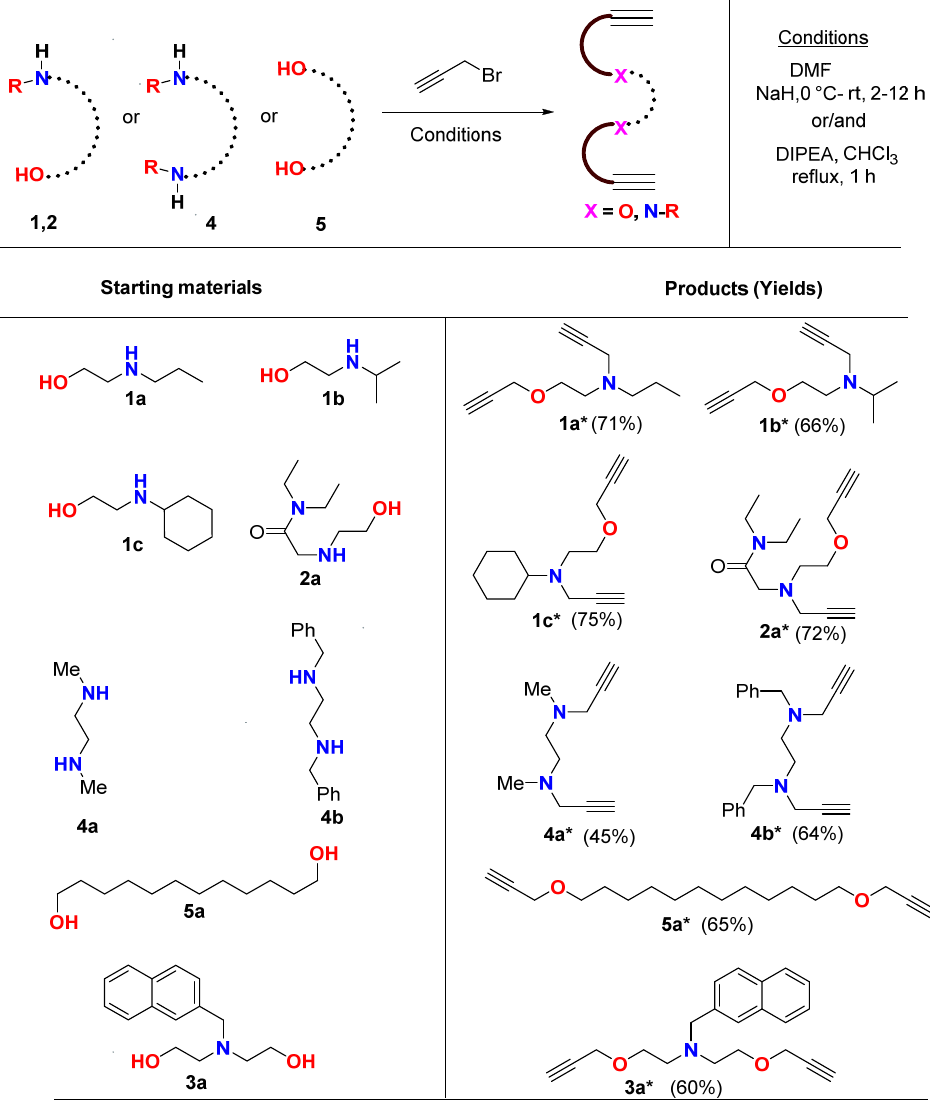
Figure 1. Synthesis of macrocyclic precursors (bis-alkynes).